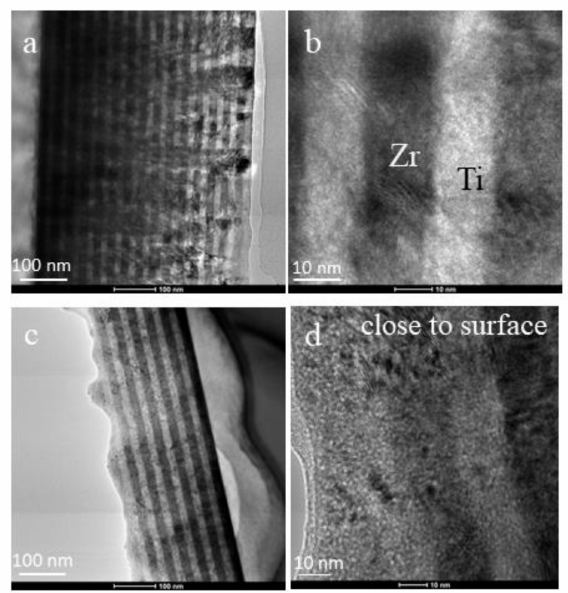
Figure 5. TEM images of a cross-section view for ( a ) a whole unmodified 15 × (Ti / Zr) / Si multilayer thin film, ( b ) part of an unmodified structure at high magnification, ( c ) a whole laser-modified 15 × (Ti / Zr) / Si multilayer thin film, and ( d ) part of a modified structure close to the